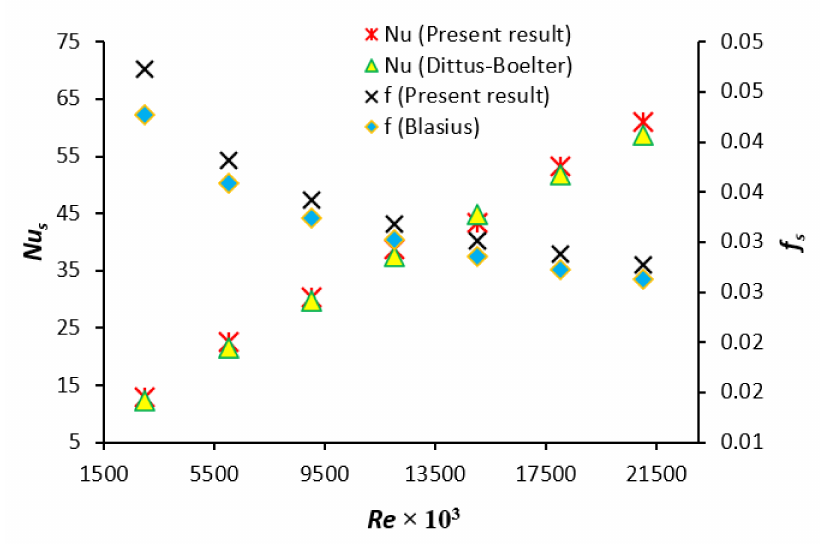
Figure 3. Validation of smooth tube result with standard equations for Nu and f .